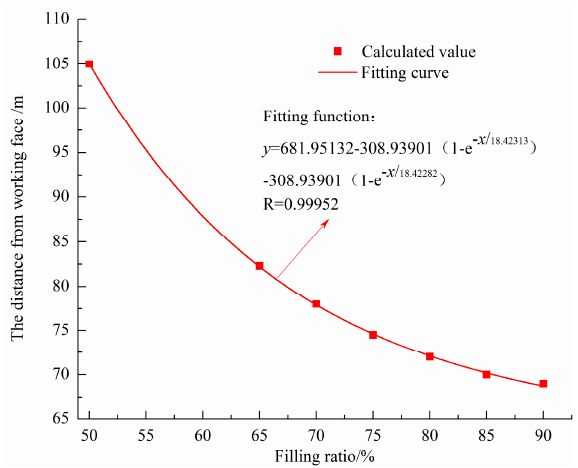
Figure 14. The distance from working face when backfill body internal pressure is stable under the condition of different filling ratios